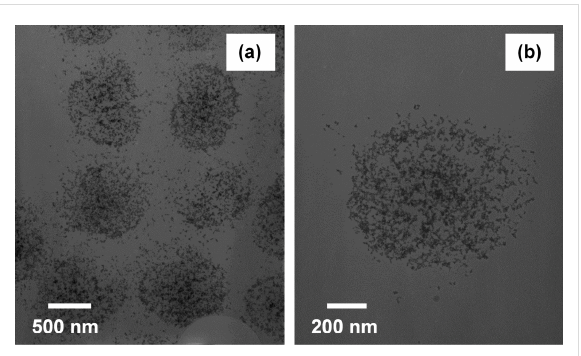
Figure 2: TEM images of (a) THPC gold seeds on pDADMAC-modfied hydrogel particles (low magnification) and (b) THPC gold seeds on pDADMAC-modified hydrogel particles (high magnification, ≈ 850 nm in